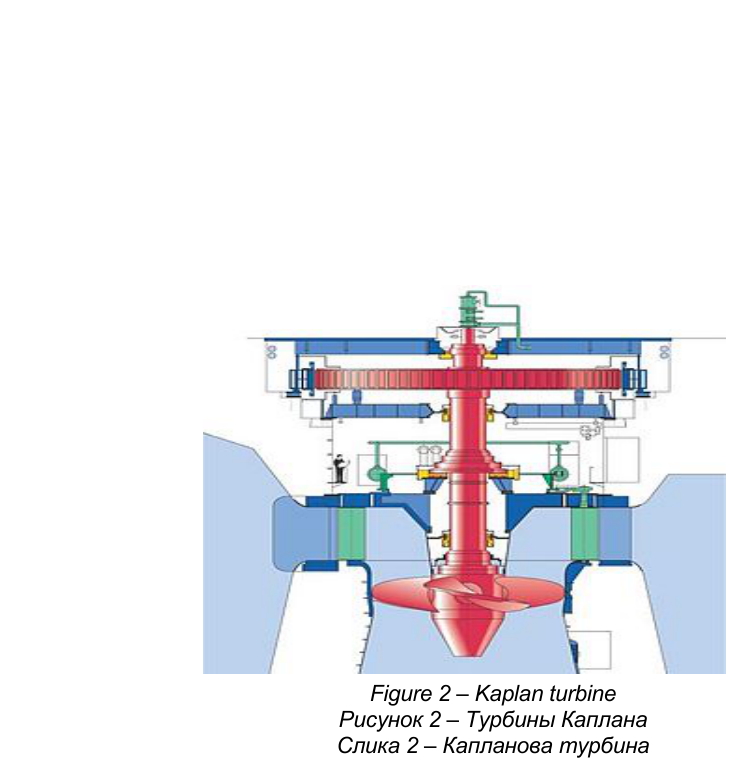
Figure 2 – Kaplan turbine Рисунок 2 – Турбины Каплана Слика 2 – Капланова турбина